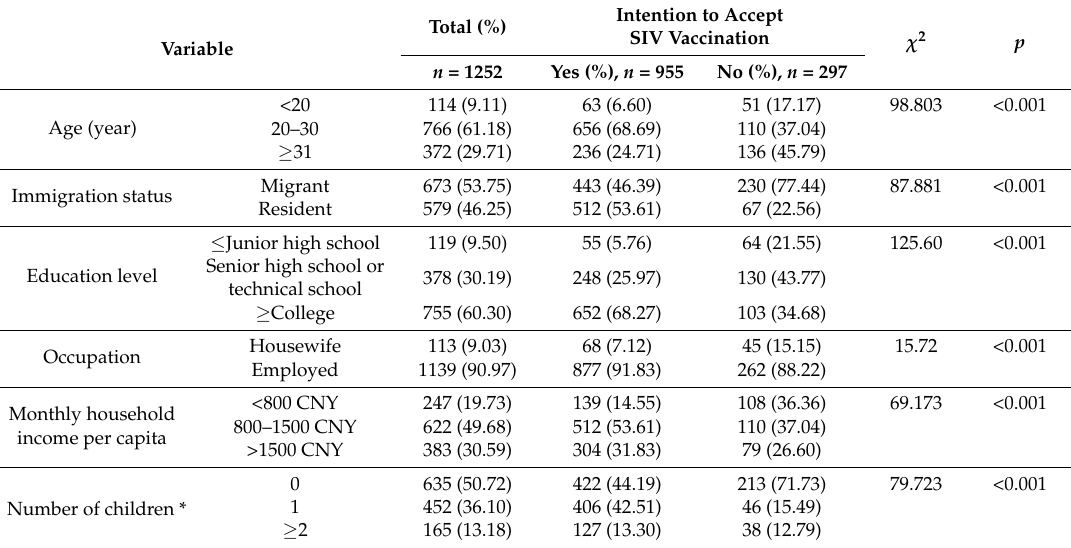
Table 1. Descriptive demographic characteristics of pregnant women by acceptance of SIV vaccination, in Zhejiang province,